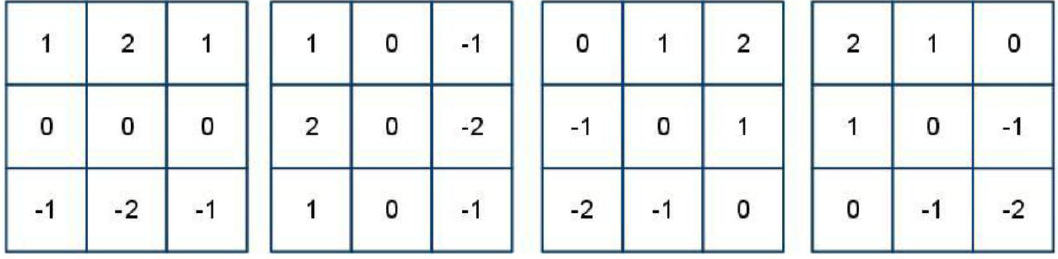
Figure 12. Example illustrating the result from applying a Sobel operator. The fused ROIs are filtered using Sobel operators in the different orientations used to emphasize the edges in specified directions. For example, the Sobel operator of 0 degrees is used to emphasize horizontal line edges. The four Sobel operators are applied to convolute each pixel in the fused ROIs and generate four values. The maximum value from these four generated values is selected as the gray level of pixels in the enhanced ROI. The enhanced ROI is shown in Figure 12. 4.2. LLF Extraction Because the line edges of the fused ROIs are enhanced using Sobel operators, it is crucial to accurately extract the LLFs. The capture of palm and palm-dorsum images at different times induces a variable environmental condition of different images. Therefore, a fixed threshold is not suitable to extract LLFs. The proposed method adopts the iterative threshold selection technique [23] to extract the line feature pixels of enhanced ROIs. The procedures are outlined as four steps as will be briefly described as follows: Step 1. Randomly initialize the threshold Th (1) (between the range of 0 to 255) to segment the image into the object and the background. Step 2. Apply Equations (8) and (9) to iteratively compute μ B ( i ) and μ o ( i ) as the means of the background and object gray levels at the i-th iteration, respectively. The threshold Th ( i ) used to segment images into the background and object is determined in Step 3 of the previous iteration by using Equation (10). ( , )